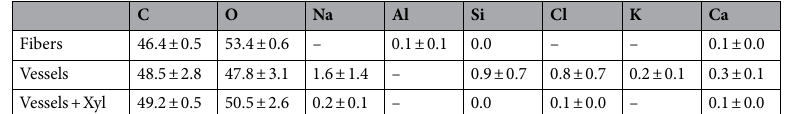
Table 3. EDX mass elemental composition (%).